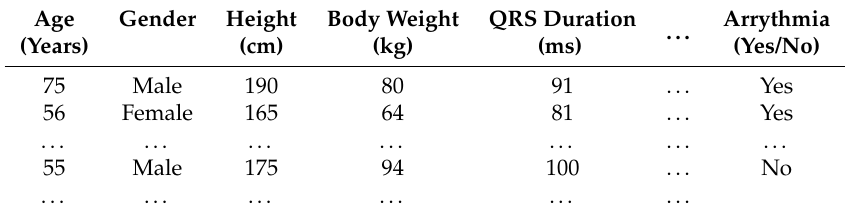
Table 1. An illustration of the adopted arrhythmia dataset, originally collected and described in detail by Guvenir et al. [22]. It comprises 279 input variables, of which only a small selection is shown here, and the corresponding target variable which for the purpose of the present experiment can be considered to be binary valued, taking on the value 0 when arrhythmia is not diagnosed and 1 when it